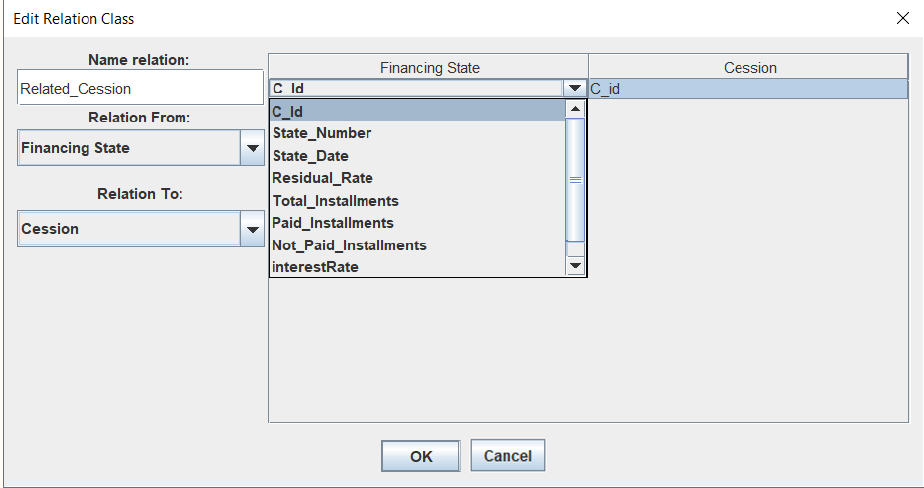
Figure 12. RADAR Knowledge Designer : screenshot of the Relationship Designer